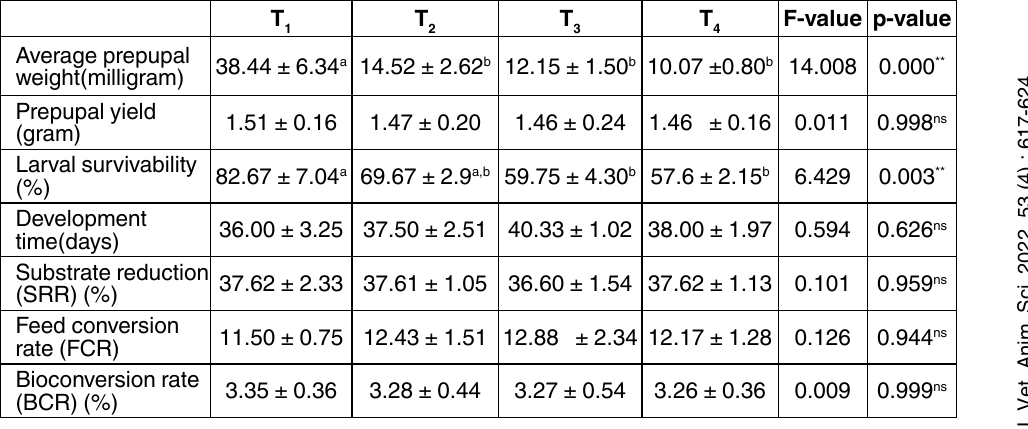
table 1 . Parametersrelated to substrate reduction and prepupal